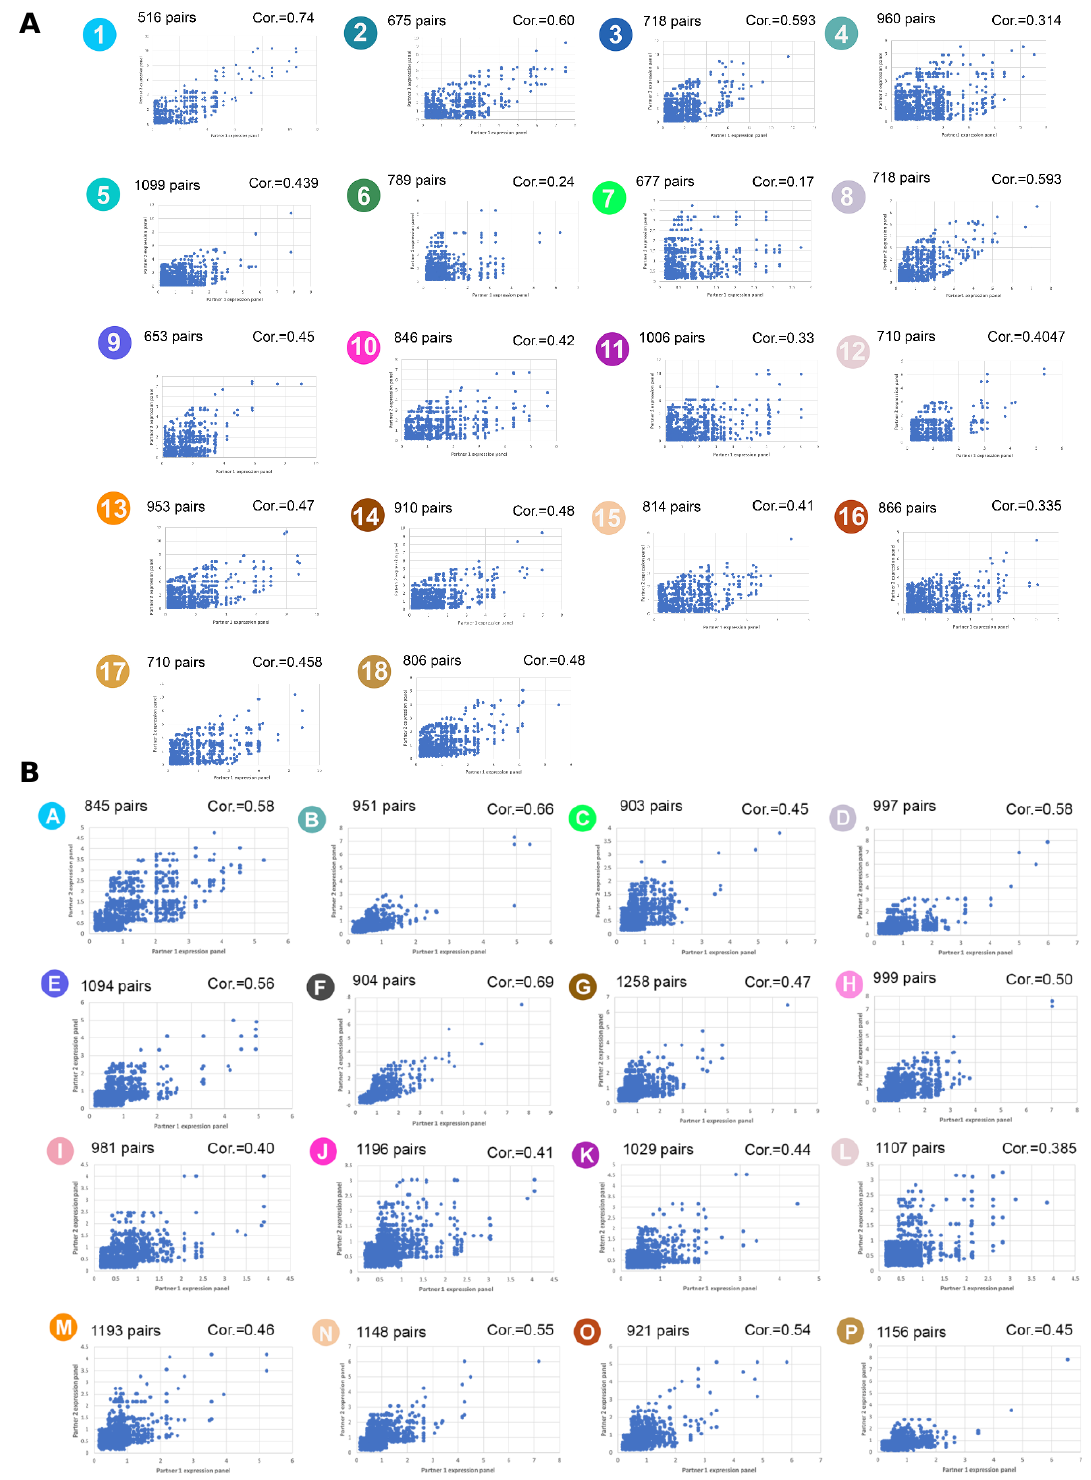
Figure 2. Correlation analysis of the expression of Arabidopsis genes encoding for interacting membrane-associate proteins. For each protoplast- (( A ), clusters 1 to 18) and nuclei-based (( B ), clusters A to P) cluster, the average numbers of UMIs per protoplast/nuclei of each gene composing the pair are indicated on the x-axis and y-axis. For each cluster, The total number of pairs with both genes expressed is indicated, as well as the coefficient of correlation between the expression of the two genes.